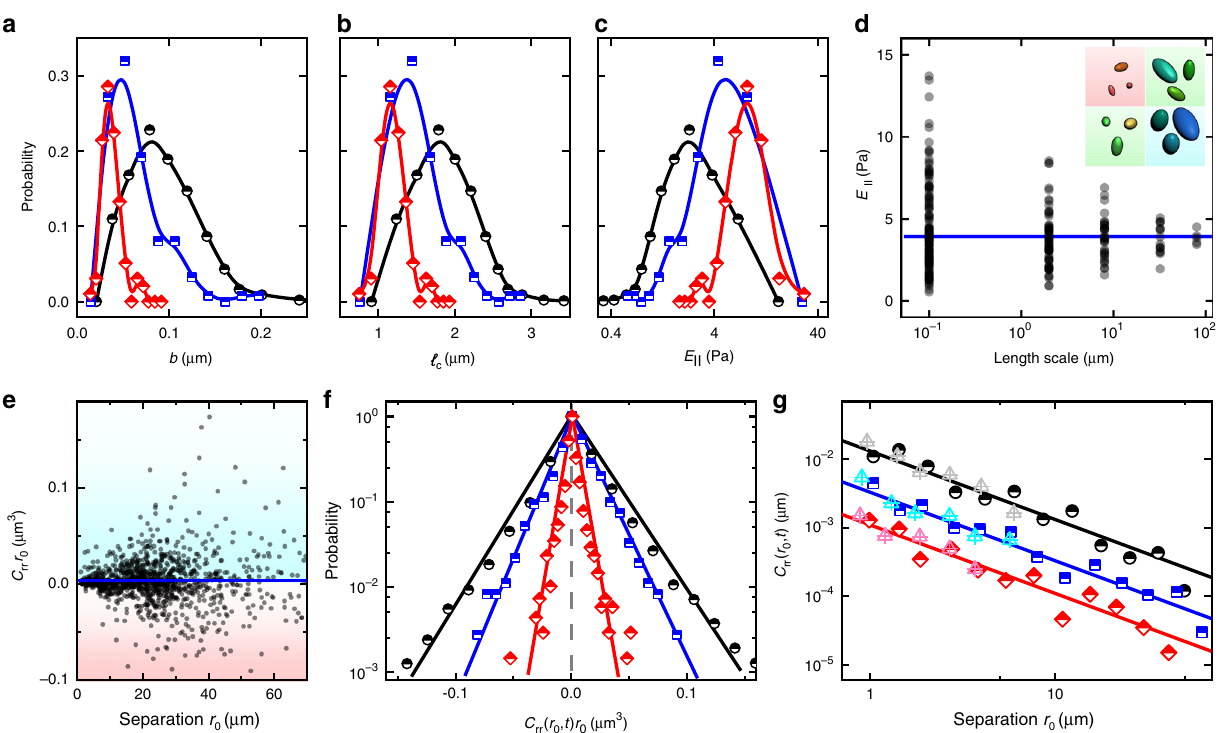
Fig. 4 Statistics of single-crosslink fl uctuations, local elasticity and two-crosslink cross-correlations. a – c Probability distributions of crosslink fl uctuation ( b ), local crosslink distance ( l c ), and local elasticity ( E ║ ) and their dependence on crosslink concentration. Lines are guides to the eye. d Mesoscopic elasticity averaged over a tile. The points converge to a common mean (blue line) with larger tile size. e Distribution of C rr r 0 against r 0 . Scatter shows individual crosslink pairs and blue line shows their average. The positive and negative region is shaded by cyan and pink, respectively. f Probability distribution of C rr r 0 displays a peculiar unsymmetrical, triangular shape. Points are experimental data and lines are exponential fi ts. g Dependence of C rr on separation for intra- fi lament (light points) and inter- fi lament (heavy points) crosslinks. The lines are the classic hydrodynamic continuum prediction 1/ r the data for an entangled, uncrosslinked network in Supplementary Fig. 2. In a – c , f , and g , biotin concentrations are 0.5, 1.5, and 3% for black, blue, and red points, respectively. In d , e , biotin concentration is